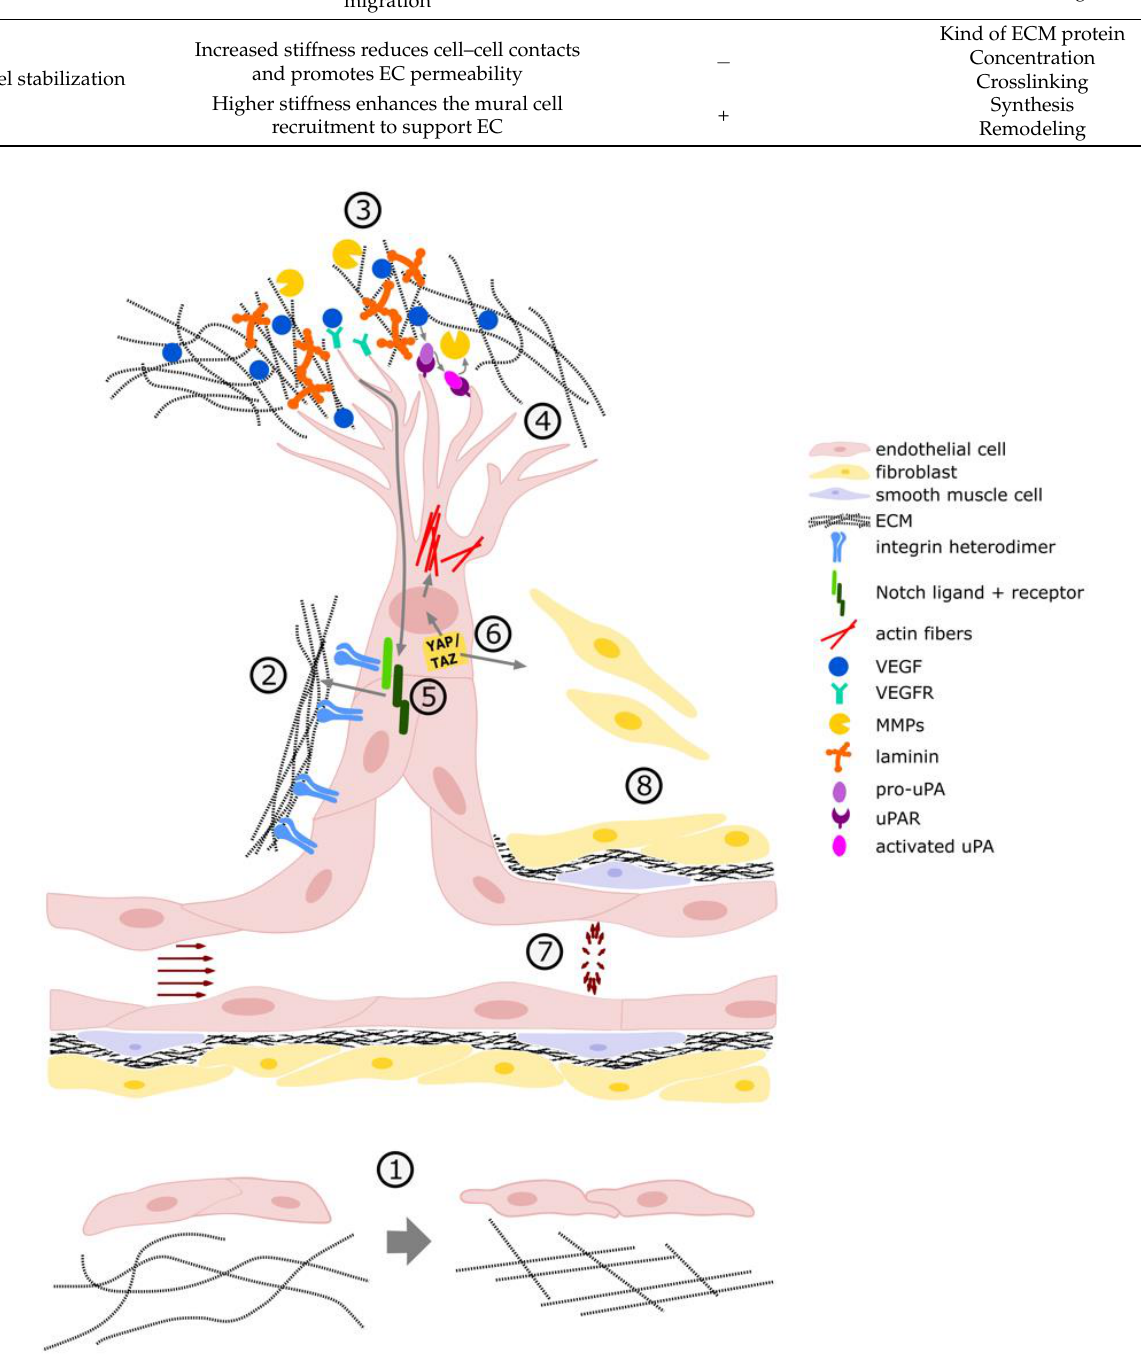
Figure 2. Mechanical aspects of angiogenesis. 1: increased matrix stiffness leads to increased migration; 2: enhanced matrix elasticity (increased stiffness) for tip cell to break out of existing vessel; 3: uPA/uPAR mediated ECM degradation by MMPs; 4: filopodia branching for tip cell direction; 5: VEGF mediated activation of the Notch signaling pathway, increased cell-matrix connections of stalk cells via NICD integrin interactions; 6: activation of YAP/TAZ by mechanical cues influ- encing the migration and filopodia formation via matrix remodeling, YAP/TAZ further supports ECM formation for vessel stabilization; 7: mechanical stimuli exerted by the blood flow; 8: vessel stabilization by mural cell recruitment.